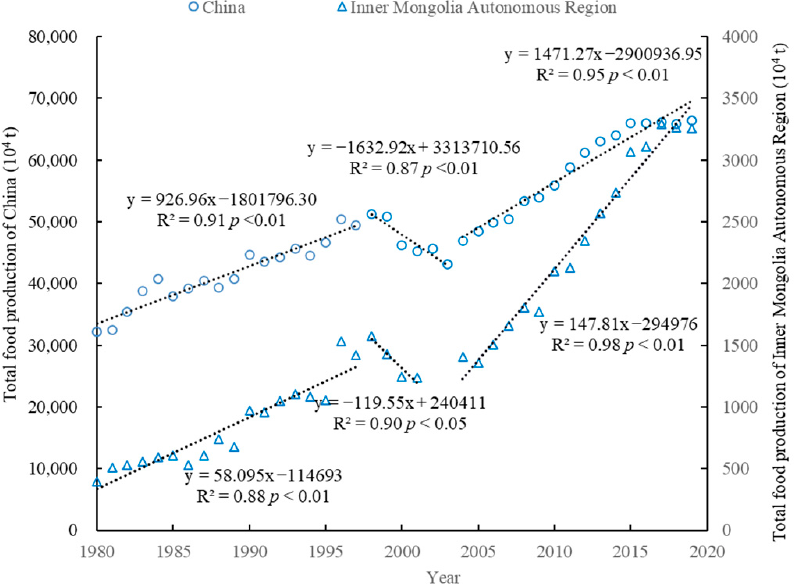
Note: Different letters between treatments represent significant differences at p < 0.05.